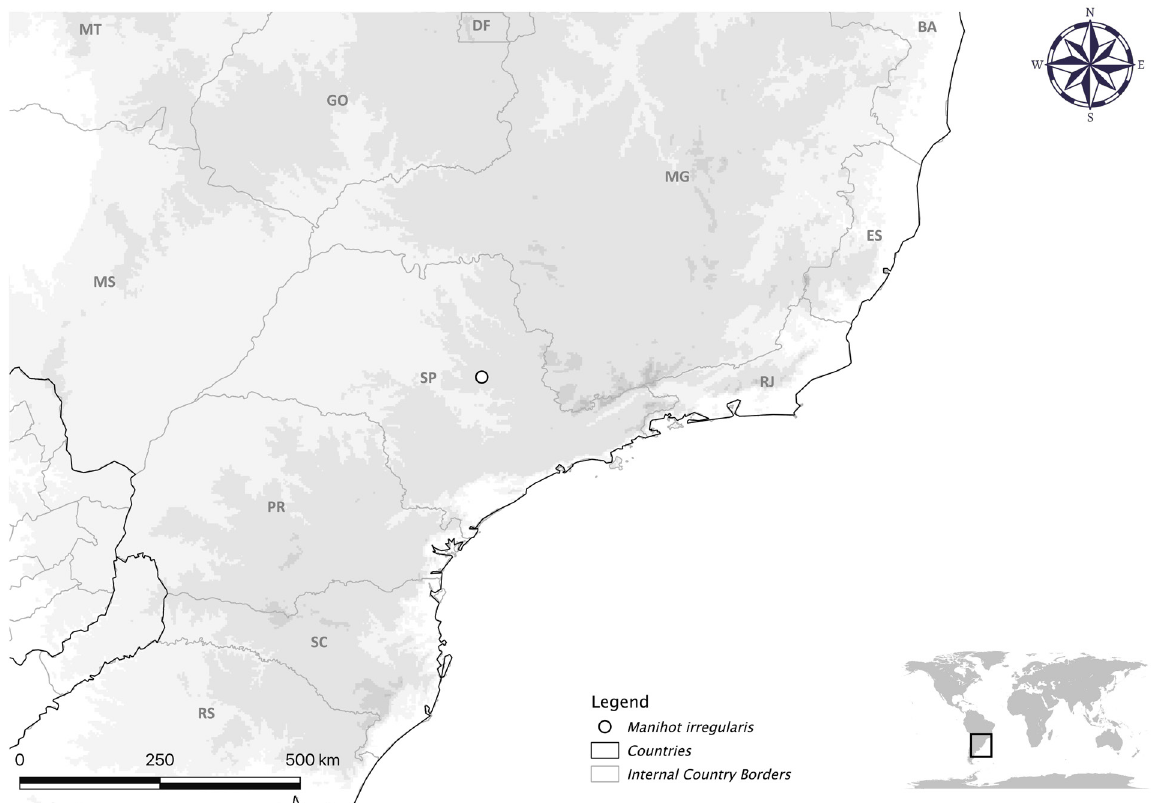
Figure 3. Geographic distribution of Manihot irregularis M. Martins &